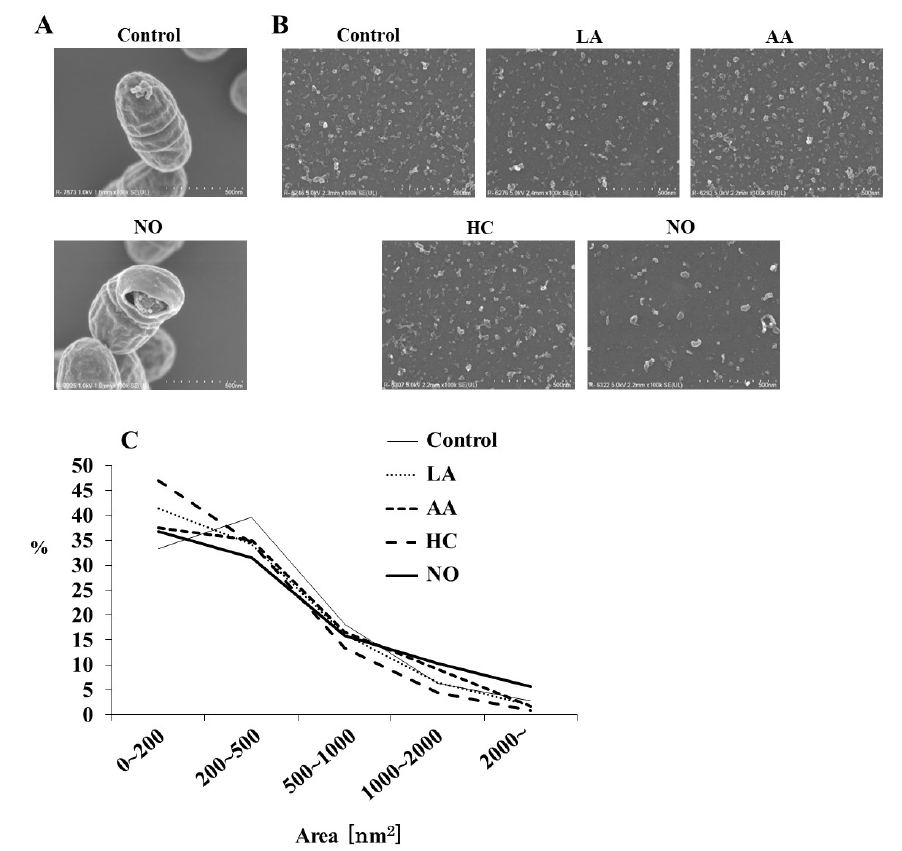
Figure 1. SEM analysis of S. mutans MVs. S. mutans UA159 with MVs in control and initial pH